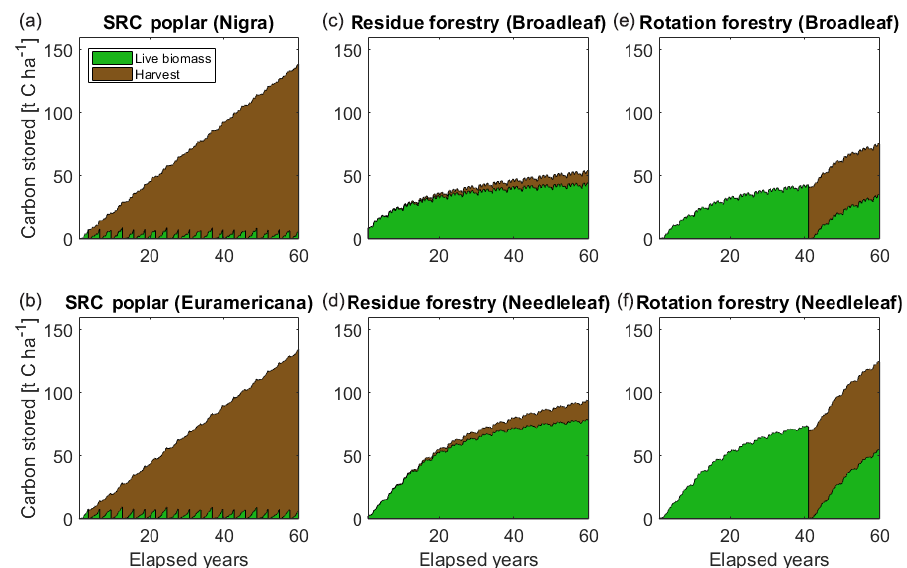
Figure 9. Illustrated cumulative harvests and vegetation regrowth over a 60-year period, showing the application of JULES-BE to short- rotation coppicing (a, b) ; permanent forestry with harvest of wood litter (c, d) , and rotation forestry (e, f)